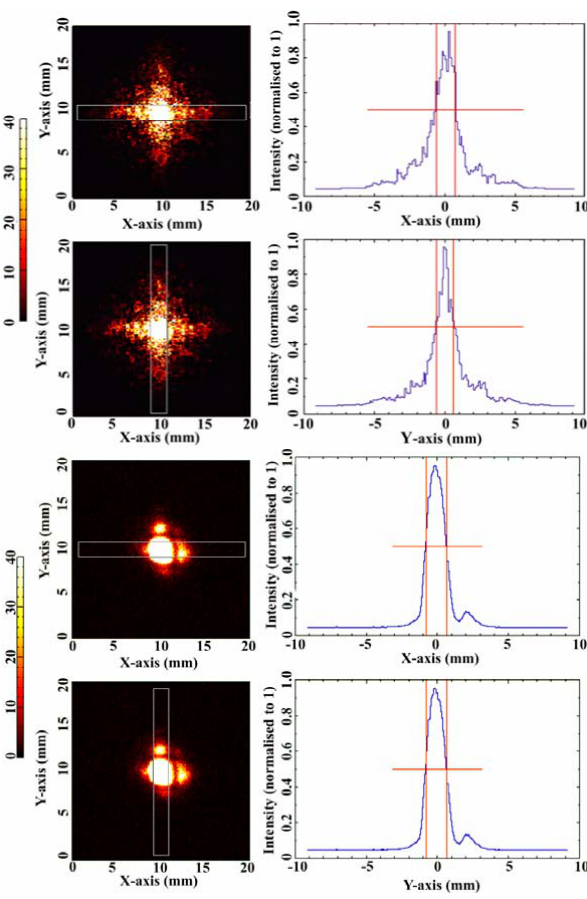
Fig. 7 . Upper panel: Simulated optic performance at a wavelength of 121.6 nm. Channel misalignments have been modelled by introducing an additional tilt to each channel. The size and direction of each tilt is taken from a Gaussian distribution with a FWHM of 1.47° in the x-axis and 1.70° in the y axis. The resulting focal spot has a FWHM of 2.45° ± 0.2° (horizontal) and 2.64° ± 0.2° (vertical). Lower panel: laboratory measurements. Cross-arm structures characteristic of a square-pore MCP optic are clearly visible. The FWHM of the central focus is 2.38° (horizontal) x 2.70° (vertical) ± 0.22°.